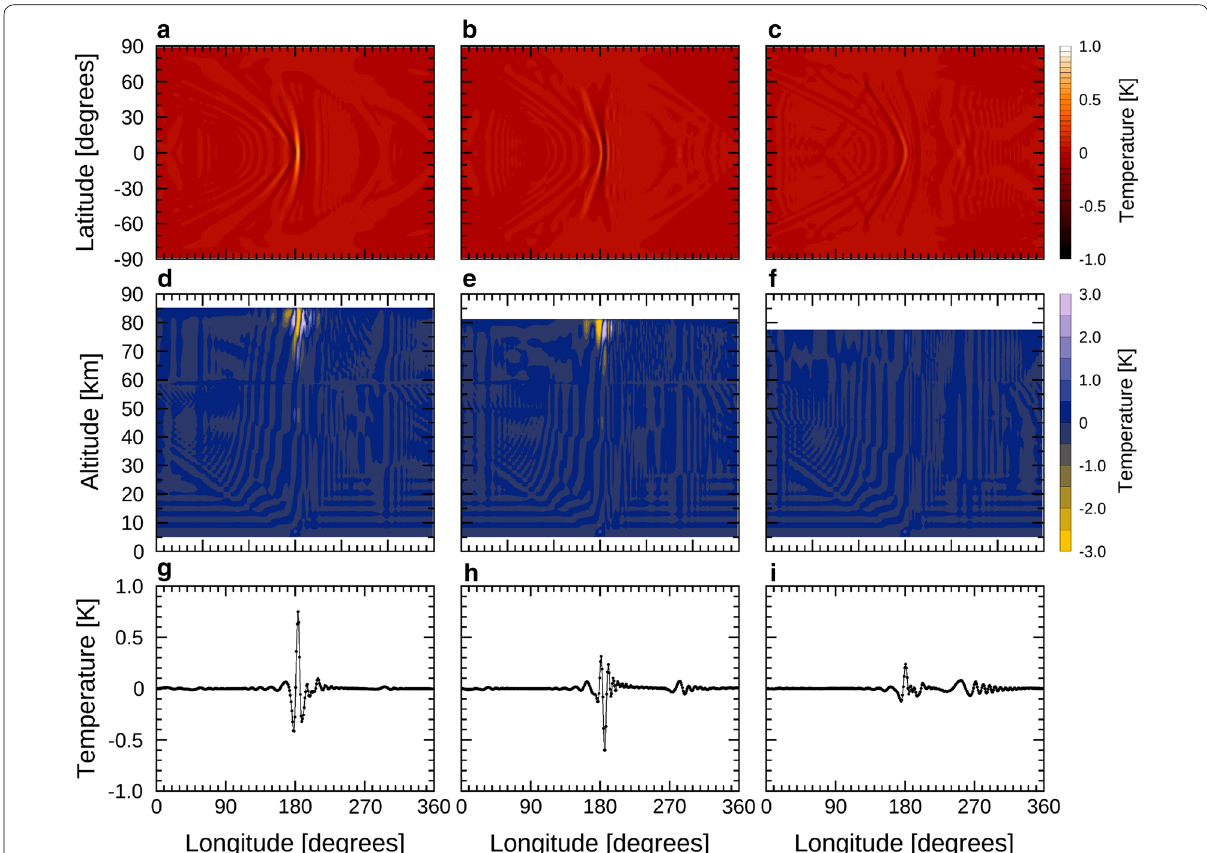
Fig. 6 Horizontal structures of the temperature disturbance, longitude–altitude cross section of the temperature disturbance on the equator, and longitudinal profiles of the temperature disturbance along the equator for the cases of the neutral layer thicknesses of 5 km ( a , d , g ), 10 km ( b , e , h ), and 15 km ( c , f , i ) (see Fig. 2). Note that regions of 3 K and above were filled with purple, and regions of e , f